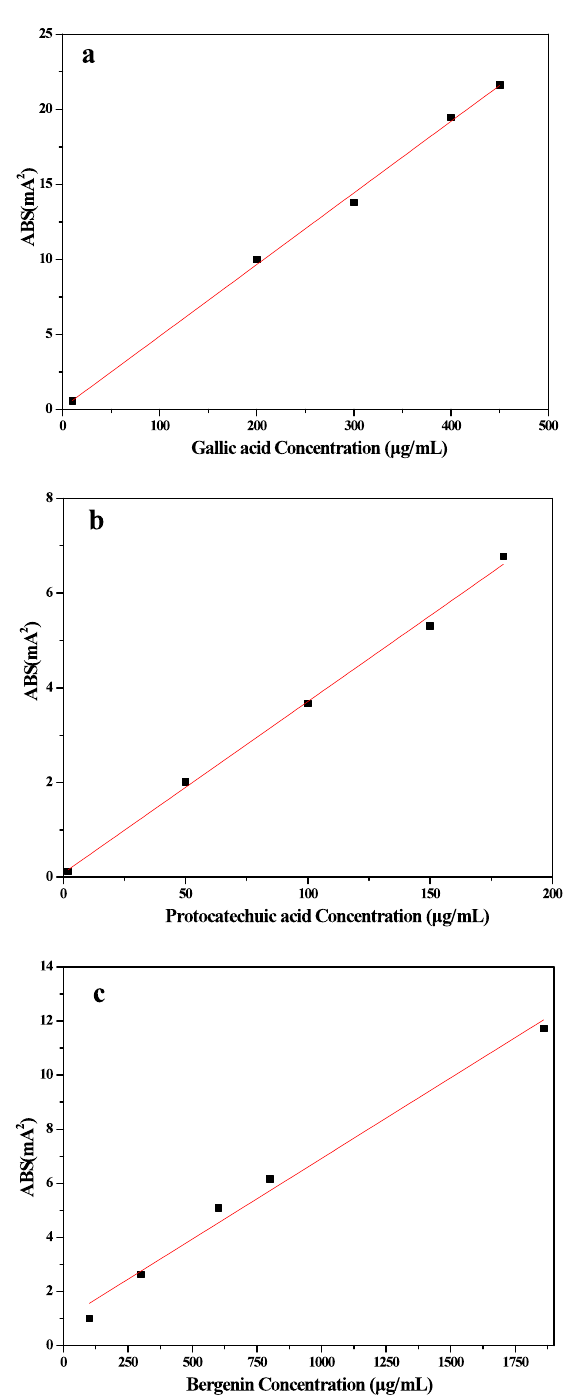
Fig. 3: Standard curves of samples concentration and their absorption at 275 nm. a, b and c represent the curves of standard gallic acid, protocatechuic acid and bergenin, respectively.